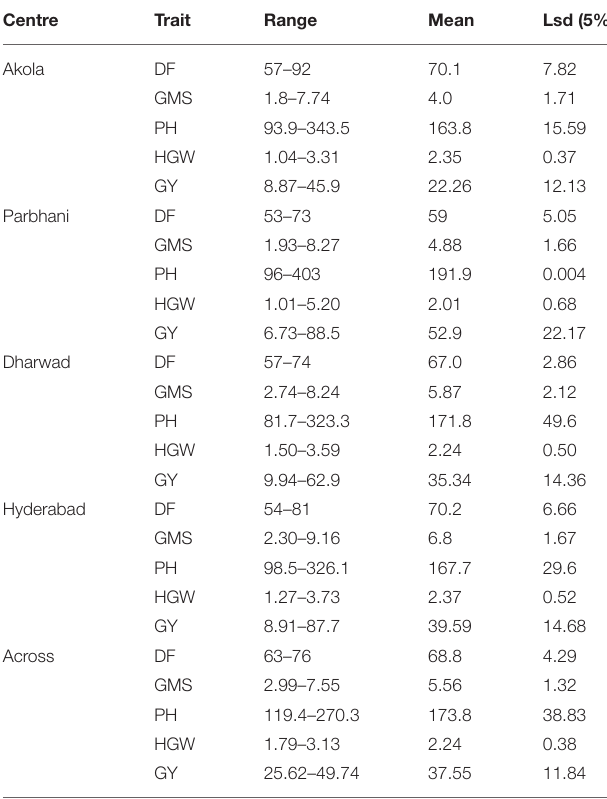
TABLE 1 | Mean performance of all genotypes at different locations during the rainy season of 2017.